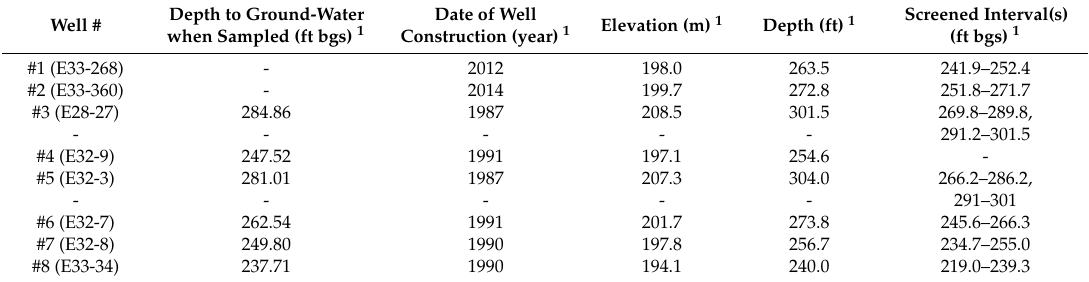
Table 1. Selected information on the wells sampled for this study (for more detailed information, see Table S1). Well #1 (E33-268) is an extraction well. Wells #2–#8 are monitoring wells.